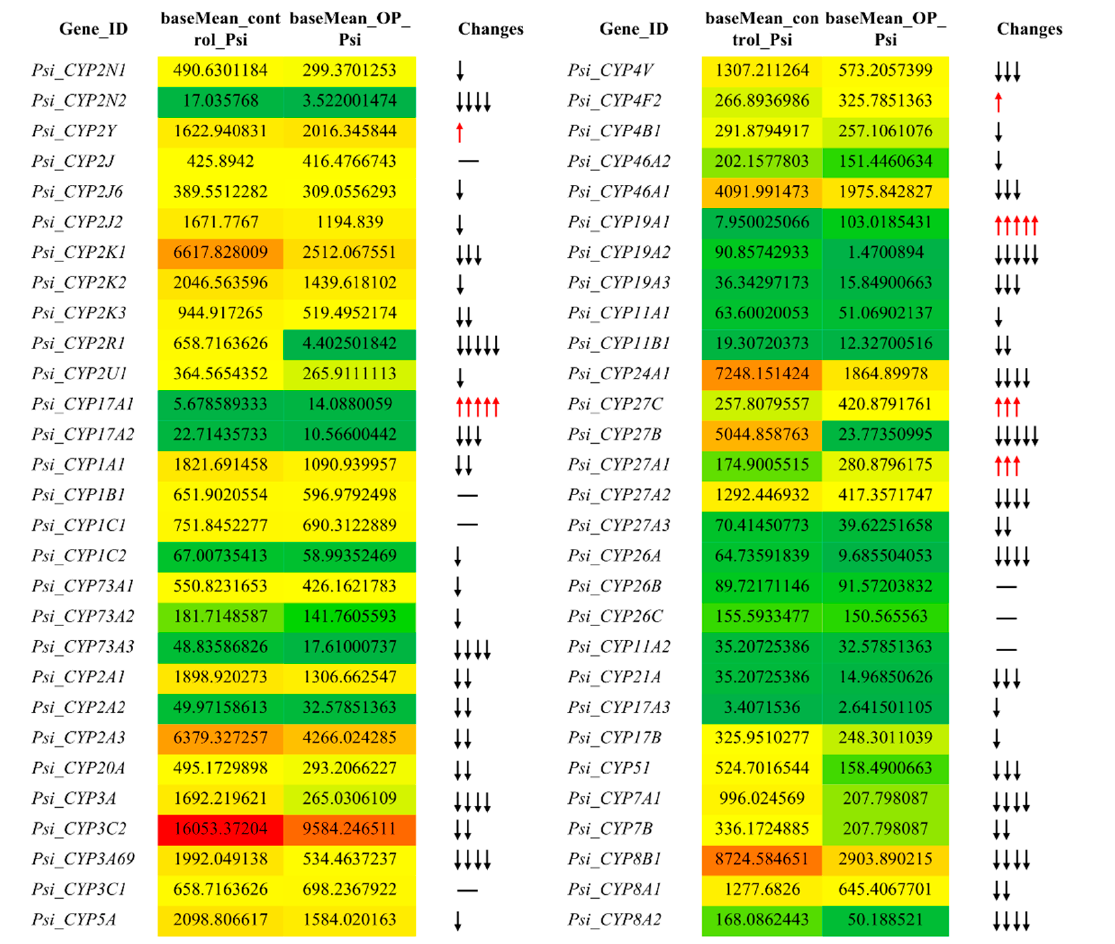
Figure 5. Expression profile changes of the P. sinensis CYP genes following dimethoate treatment.